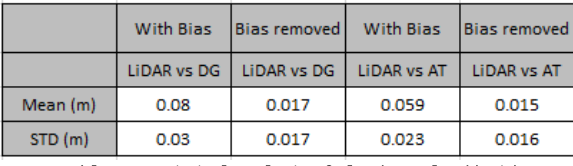
Table 6: Statistical analysis of cloud-to-cloud height differences.